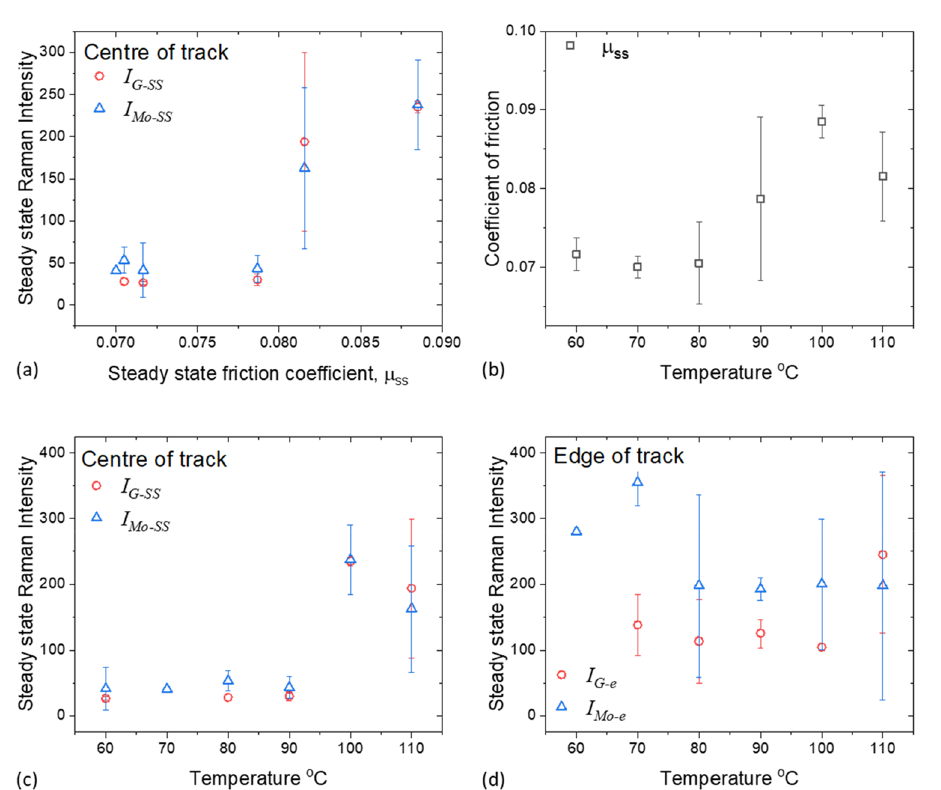
Figure 6. ( a ) The relationship between steady-state Raman intensities of MoS 2 , G-band obtained at the contact track, and steady state friction coefficient, temperature: 60–110 °C and Load = 70 N; the effect of test temperature on ( b ) friction coefficients; ( c ) steady state Raman intensities of MoS 2 , and G-band obtained in the contact track; ( d ) steady state Raman intensities of MoS 2 , and G-band obtained at the edge of the contact track. Note the Raman intensity of D-band is similar to that of G-band in all cases and is omitted for